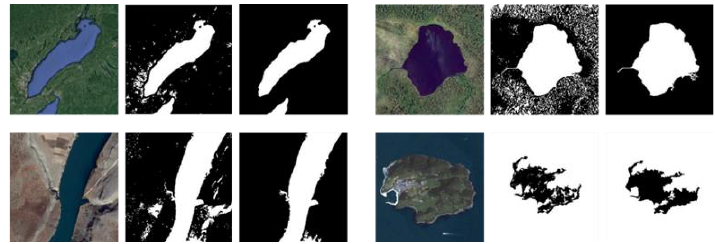
Figure 4. Results of segmentation after processing on lake, river and island.